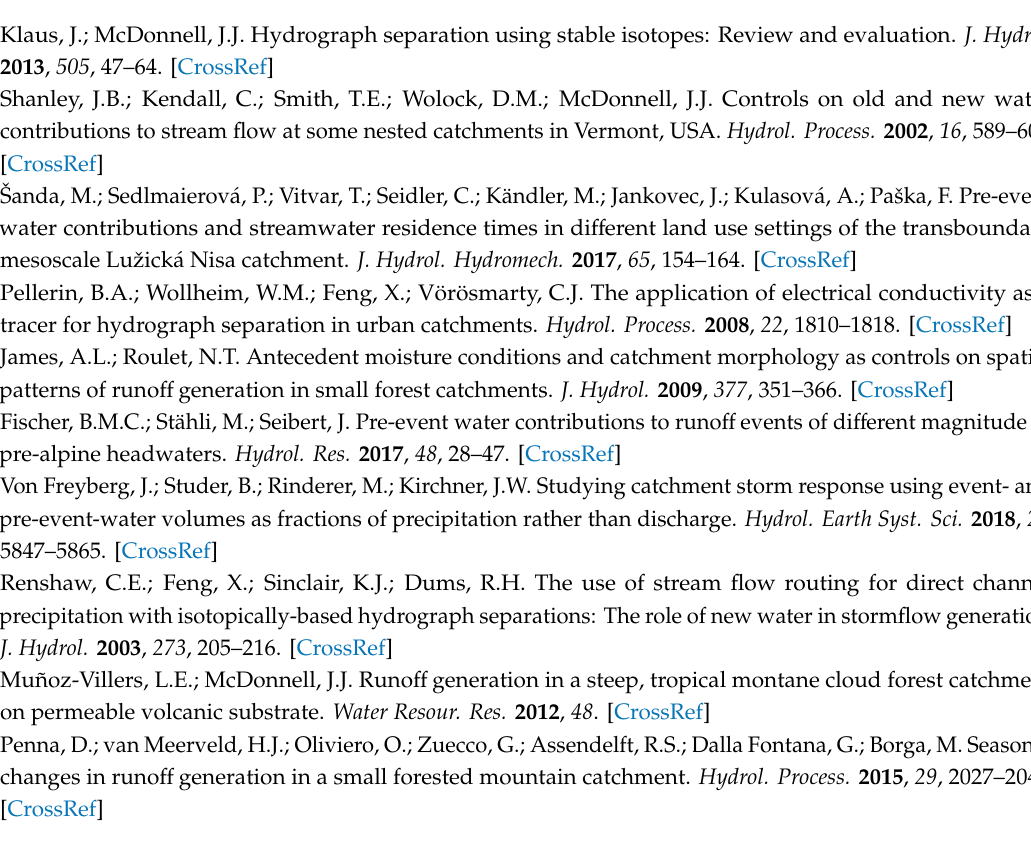
Table S1: Precipitation, antecedent wetness and discharge characteristics for the 20 events, Table S2: Maximum event water fraction F E , uncertainty of maximum event water fraction W F max water and groundwater sources derived from δ 2 H values for the 20 events, Table S3: Maximum event water fraction F E , uncertainty of maximum event water fraction W F max groundwater sources derived from δ 18 O values for the 20